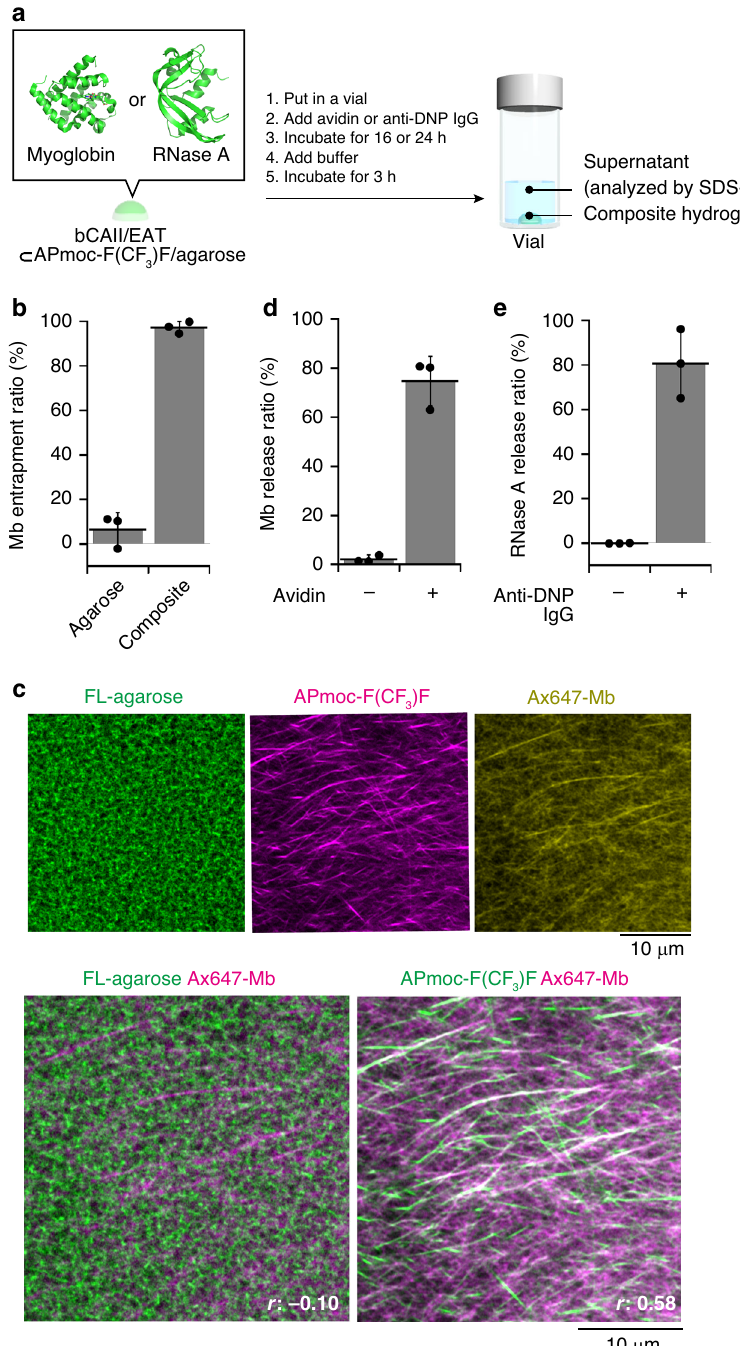
Fig. 5 Protein-responsive protein release from the composite hydrogel. a Schematic illustration of the protocol of protein-responsive protein release from the composite hydrogel. PDB ID: 5ZZE (myoglobin, Mb) and 1AFK (RNase A). b The Mb entrapment ratio of agarose and composite hydrogels ( n = 3). APmoc-F(CF 3 )F hydrogel could not be taken out of the mold. c High-resolution Airyscan CLSM images of the composite hydrogel containing Ax647-Mb (Ax647-Mb ⊂ APmoc-F(CF 3 )F /FL-agarose/ TMR-Gua ). r : Pearson ’ s correlation coef fi cient. As shown in Supplementary Fig. 31, Ax647-Mb was trapped more ef fi ciently in the composite hydrogel than the agarose hydrogel. The fi brous morphology of the Alexa Fluor 647 dye could not been observed, implying that interaction between APmoc-F(CF 3 )F fi bers and Mb is crucial (Supplementary Fig. 32). Please see Supplementary Fig. 33 for other control conditions. d Avidin-responsive Mb release and ( e ) anti-DNP IgG-responsive RNase A release from the composite hydrogel ( n = 3). Condition: [ APmoc-F [RNase A] = 0.25 mg/mL (for e ), [ TMR-Gua ] = 10 µ M (for c ), [bCAII] = 10 µ M, [ EAT(avidin) ] = 20 µ M (for d ), [avidin] = 20 µ M (for d ), [